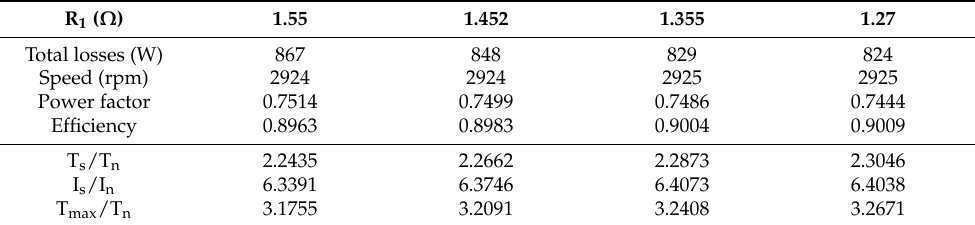
Table 6. Nominal, start, and maximum torque results on the 7.5 kW motor (equal output power criteria, variations of R 1 ).